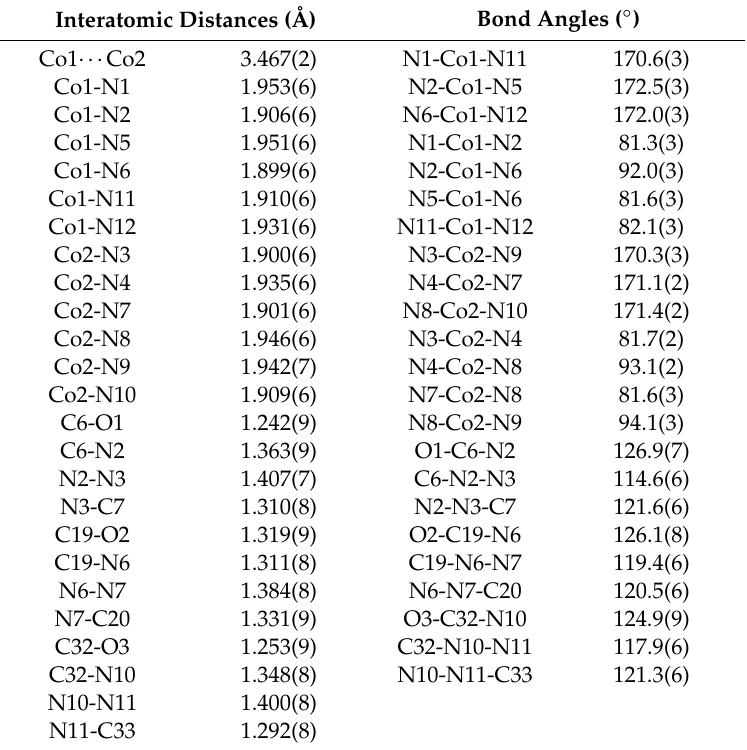
Table 4. Selected interatomic distances (Å) and bond angles ( ◦ ) for complex 3 · 0.8 H 2 O ·